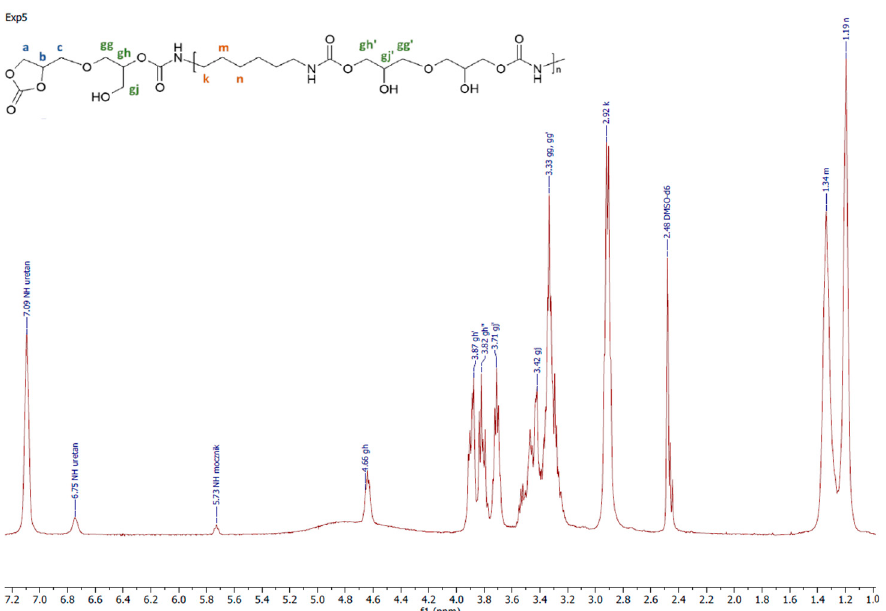
Polymers 2022 , 14 , 4510 7 of 16 Figure 4. A representative 1H NMR spectrum of PHU obtained in experiment run nos. 5, 6, 9 and 10.